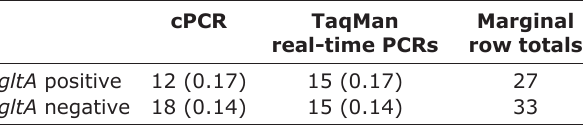
Table-6: Detection results for E. canis detection using gltA gene compared between TaqMan real-time PCR and